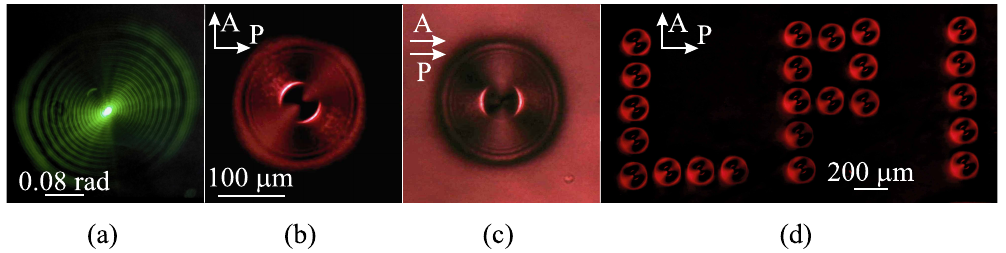
Figure 2. Far-field diffraction pattern of a probe light beam passed through the light-induced orientational structure created in the homeotropic film of 5CB + 0.2%MR + 0.02%BA ( a ). Optical microscopic images of this structure in the case of crossed ( b ) and parallel ( c ) polarizers. An example of addressed laser writing of the “LPI” pattern consisting of particle-like structures ( d ). White arrows in ( b – d ) indicate the directions of polarizer (P) and analyzer (A).